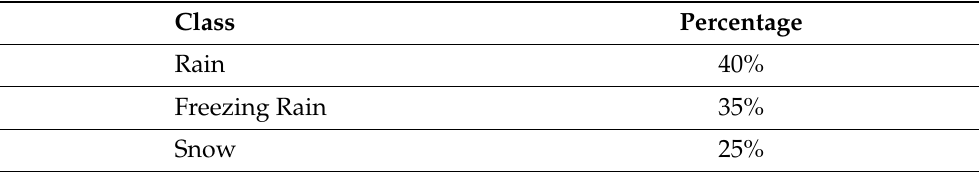
Table 3. Distribution of class